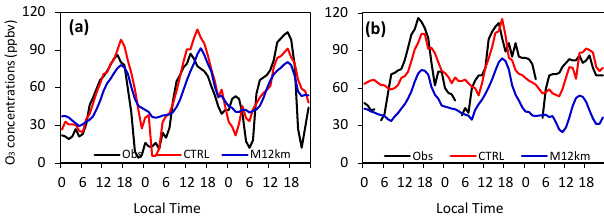
Figure 11. Ground-level ozone concentration comparisons between observations and simulations at (a) Banning Airport (ID0650012, 33.92077 ◦ , − 116.85841 ◦ ) located in the San Gorgonio Pass and (b) Crestline (ID060710005, 34.24313 ◦ , − 117.2723 ◦ ) near the Cajon Pass from 17–19 July 2005. Obs indicates the observation. CTRL represents the simulations from CTRL run and M12km is the model simulations at 12km resolution.